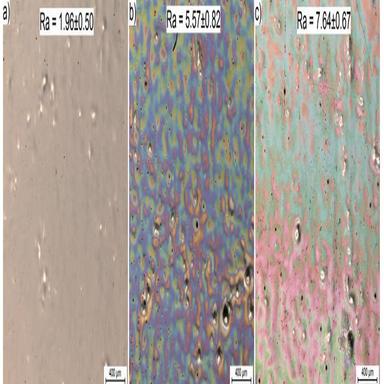
Confocal microscopy results for a) Ref_g, b) TEOS_am_g and c) TEOS_BTSE_am_g samples on the glossy side of the amorphous ribbon.